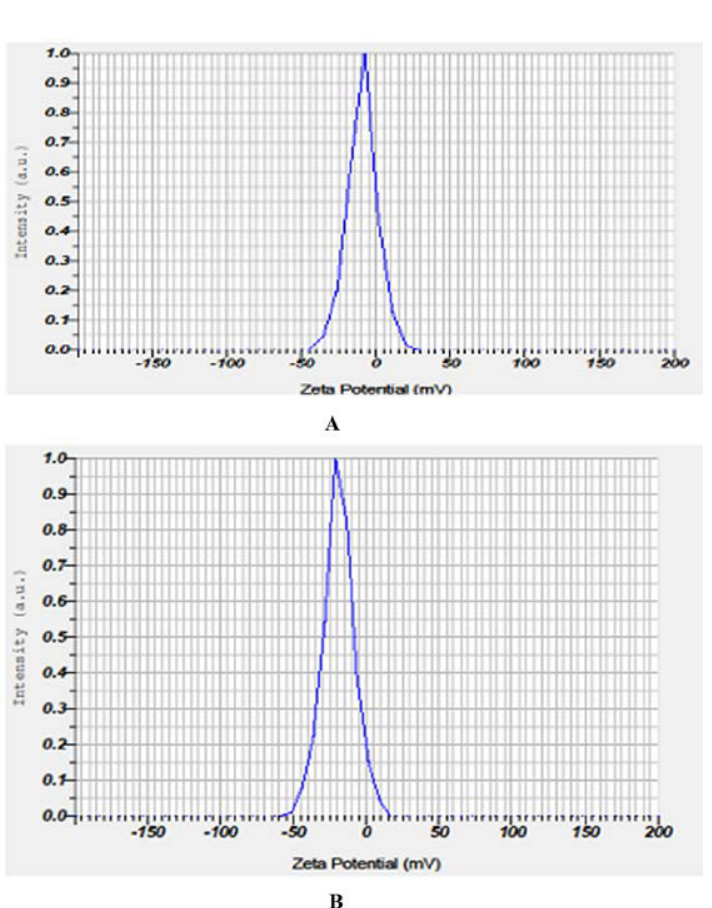
Fig. 6. Zeta Potential of Psidium guajava silver nanoparticles (A) Ethanolic extract (B) Chloroform extract